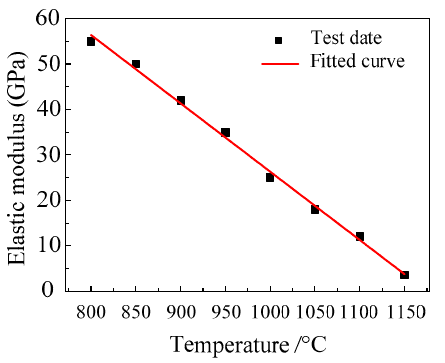
Figure 4. DSI C-Gauge sensor.